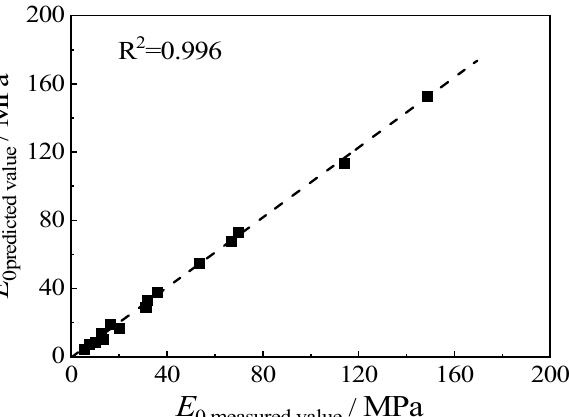
Figure 12. The relationship between the fitting parameters K and n , according to cement content. ( a ) Fitting parameters K , ( b ) Fitting parameters n . The relationship between the actual value of the initial elastic modulus, E 0 , and its predicted value is plotted in Figure 13. It can be seen that the scatter points are evenly distributed near the 45° line, and the fitting of R 2 reaches 0.996, indicating that the predicted value is close to the measured value. It can be seen that the empirical formula of the initial elastic modulus, E 0 , is reliable.